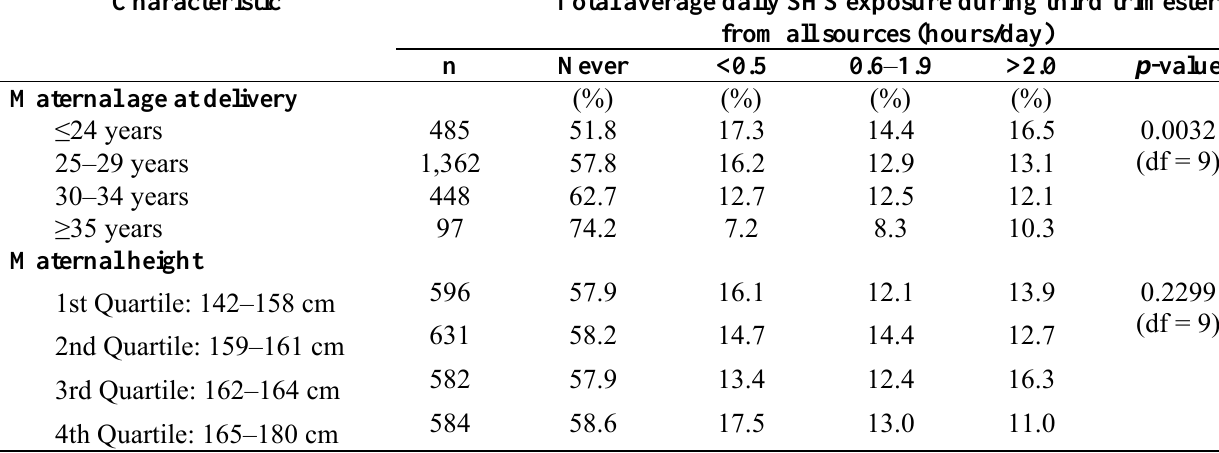
Table 7. Percentage distribution of daily average SHS exposure times during third trimester of pregnancy by parental and perinatal